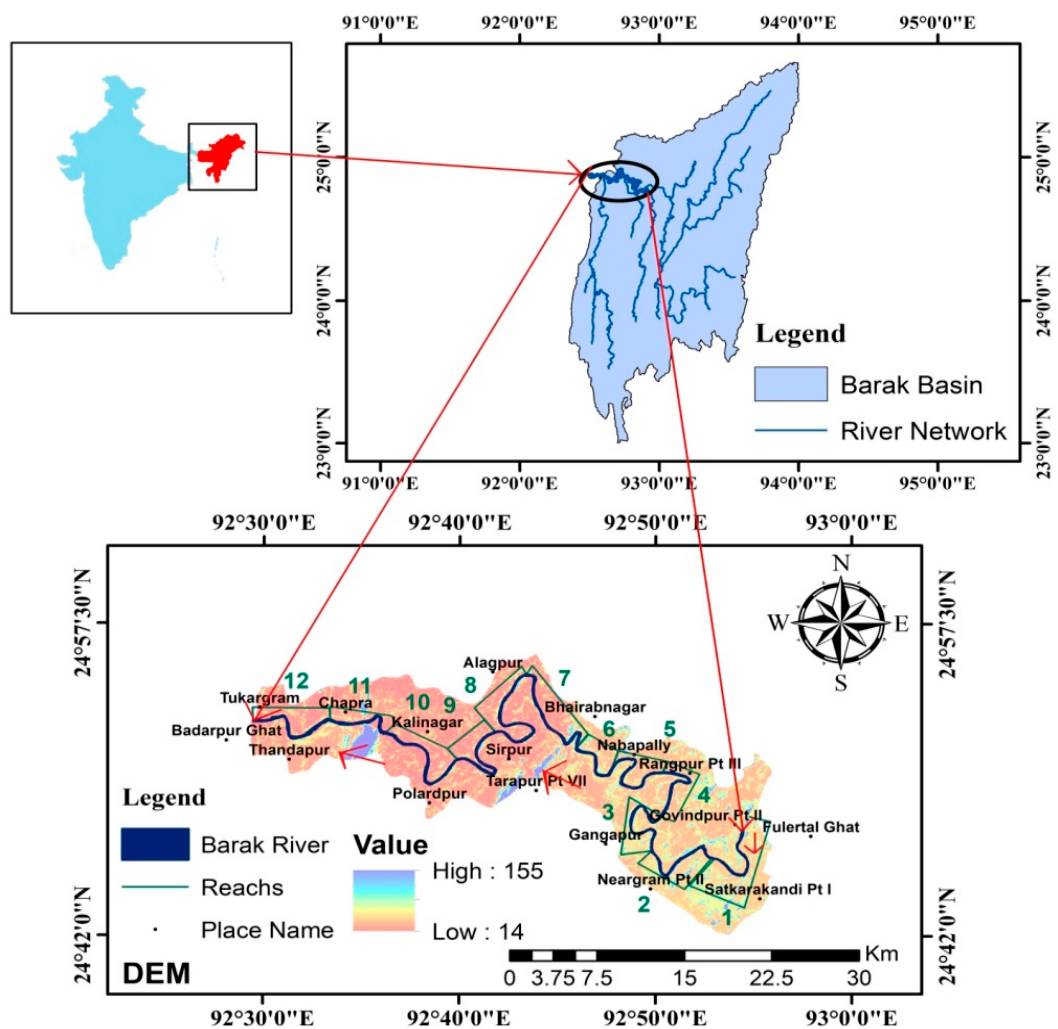
Figure 1. Location map of the study area showing 12 meandering reaches of the Barak River. Table 1. List of Landsat satellite image